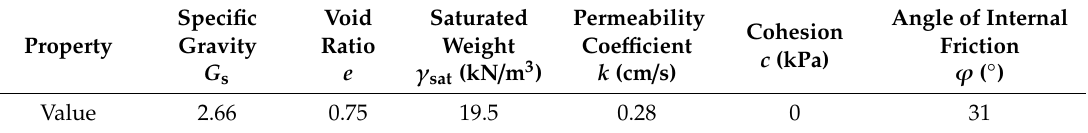
Figure 2. The siliceous sand in tests. Table 1. Properties of siliceous sand.